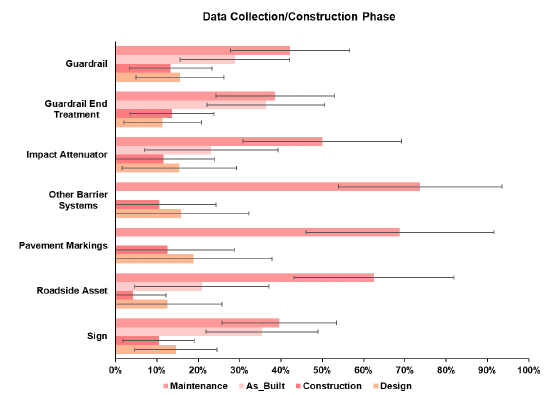
Figure 6 . Breakdown of state DOTs’ Data Collection across the different Project Phases for the different assets of the Roadside Asset Systems. Figure 7 indicates that the CIs for all Data Features across all assets overlap, indicating that state DOTs collect data on the asset indexed location, asset dimension, asset material type and properties, and asset condition for all seven assets similarly.